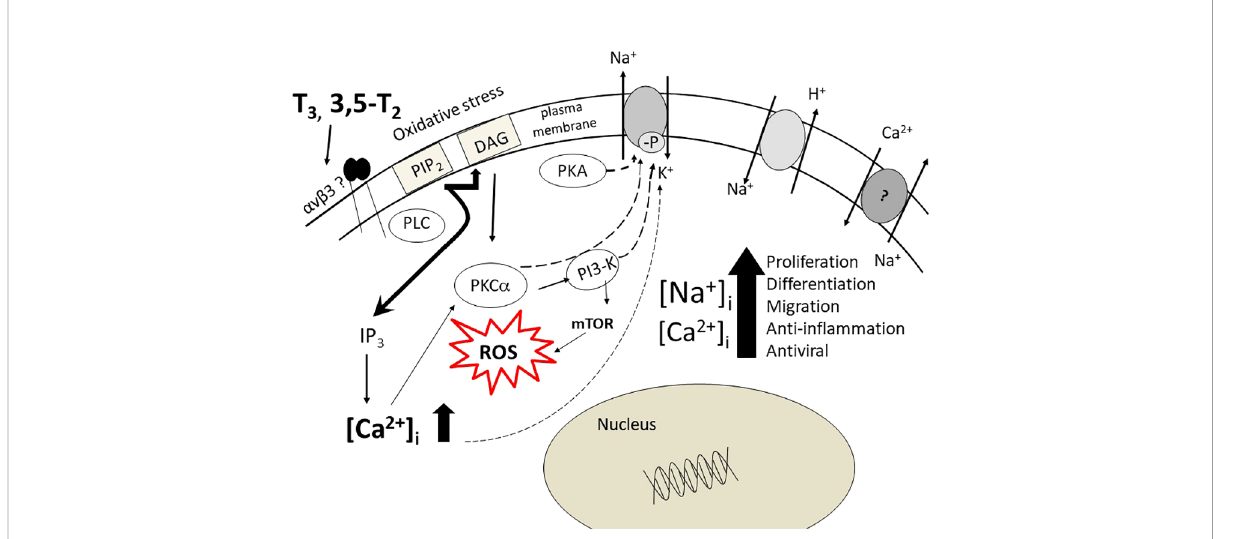
FIGURE 1 The pathways, cytosolic and nuclear, activated by thyroid hormone, T 3 , 3,5-T 2 in chick embryo hepatocytes. Here a role for integrin a v b 3 is suggested. The increase of Na + and Ca 2+ ions is achieved by modulation of the Na + /K + -ATPase activity, the Na/H-exchanger, Na/Ca-exchanger (reverse mode). The fi nal result is very similar to the activation of the a 7nAChR as to increase of [Na + ] i and [Ca 2+ ] i ions and to cytosolic and nuclear pathways, resulting in the chick embryo in a coordinated response both mitogenic and immuno-defensive, aimed to the embryo survival. The fi gure is modi fi ed from Ref.